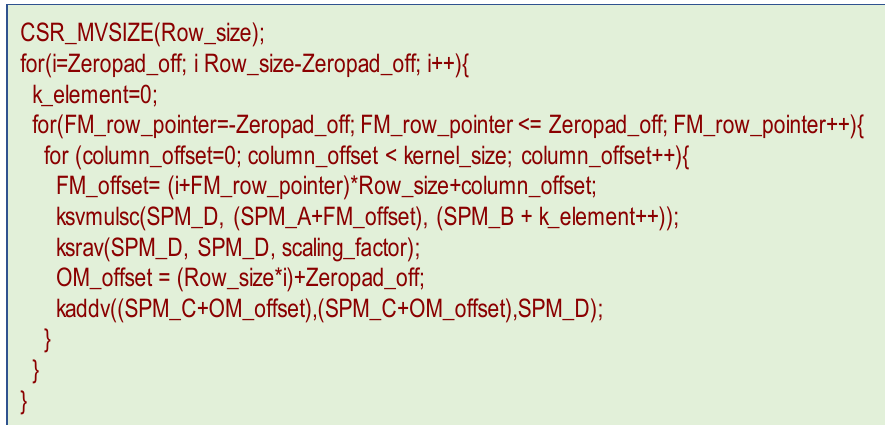
Figure 11. Convolution2D inner loops operations (Layers: 1, 2, 4, 5, 7, 8, 9, 11, 12, 13, 15, 16, 17).